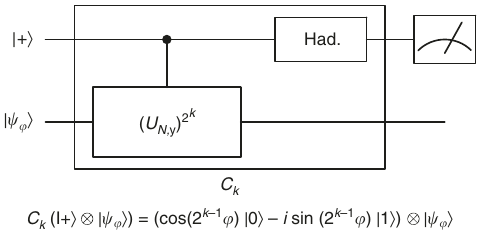
Fig. 3 Proof of Theorem 1 by Kitaev ’ s phase estimation 29 . The circuit C k is essentially a Mach-Zehnder interferometer, and U N ; y ψ φ probability to measure 1 is p k ¼ sin 2 ð 2 k (cid:4) 1 φ Þ . If (2 φ / π mod 4) ∈ {0, 3}, p 0 < 1 otherwise p 0 > 1 . Similarly, the estimation of every p k yields one bit of 2 φ / π . 2 The algorithm estimates each p k by repeating the corresponding measurement poly( n ) times, thus 1/exp( n ) accuracy of φ is reached with total complexity poly( n ): C k is ef fi ciently implemented even for k = poly( n ) using modular exponentiation to implement exponential powers of U N , y